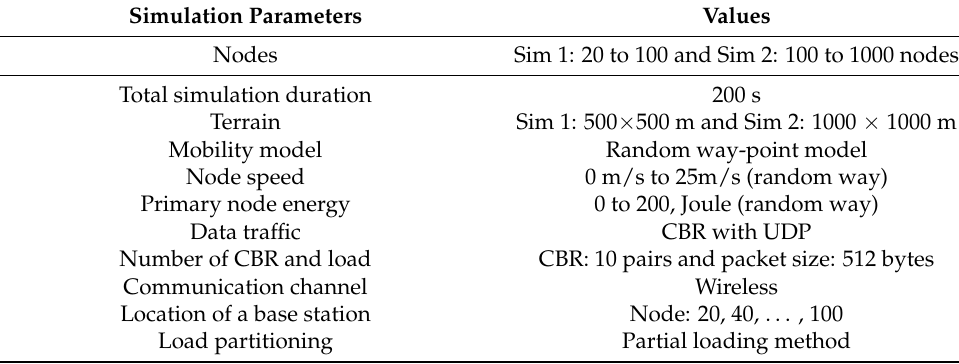
Table 5. Simulation parameters used. Simulation Parameters Values Nodes Sim 1: 20 to 100 and Sim 2: 100 to 1000 nodes Total simulation duration 200 s Terrain Mobility model Random way-point model Node